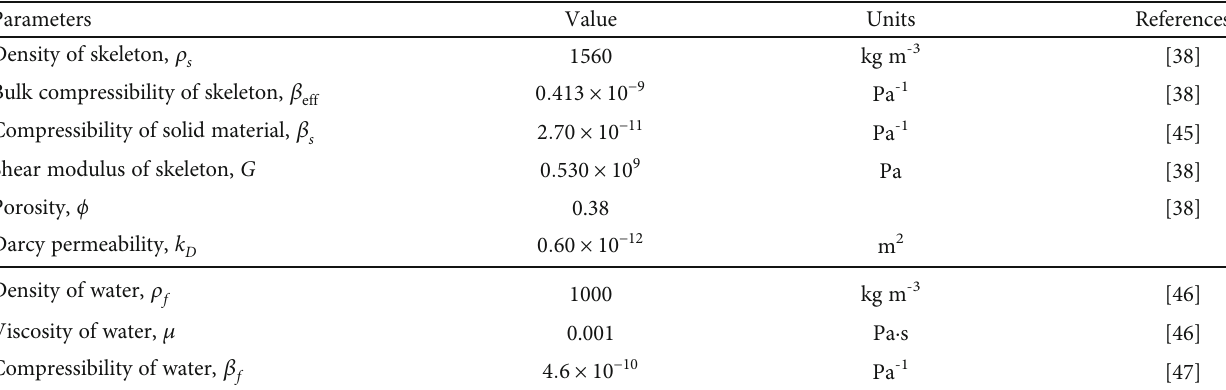
Figure 2: Same as Figure 1 except that the prediction is by the model improved with dynamic permeability k Table 2: Parameters of compressed glass beads and